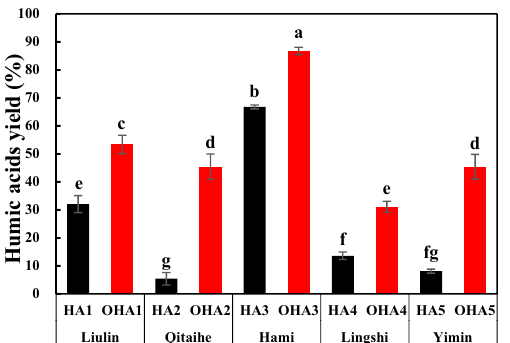
Figure 1. Yields of HAs. HA1–HA5, the HA extracted from original coal (black); OHA1–OHA5, the HAs extracted from oxidized coal (red); Liulin, Qitaihe, Hami, Lingshi and Yimin, the origin of coal.